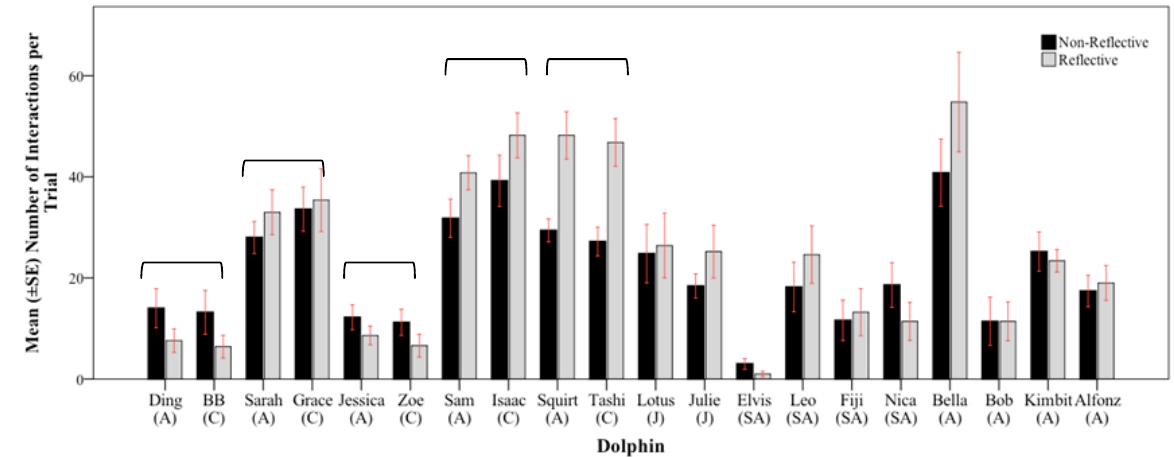
Figure 6. Mean (± 1 SE) number of interactions with the reflective and non-reflective surfaces of the apparatus for each subject ( N = 30), identified as individuals and their age class: calf (C), juvenile (J), subadult (SA), and adult (A). Brackets delineate mother-calf pairs.